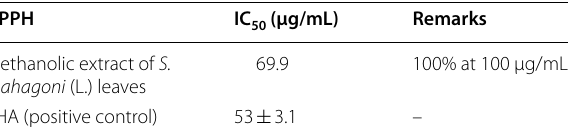
Table 5 Antioxidant activity of the methanolic extract of S. mahagoni (L.) leaves DPPH IC 50